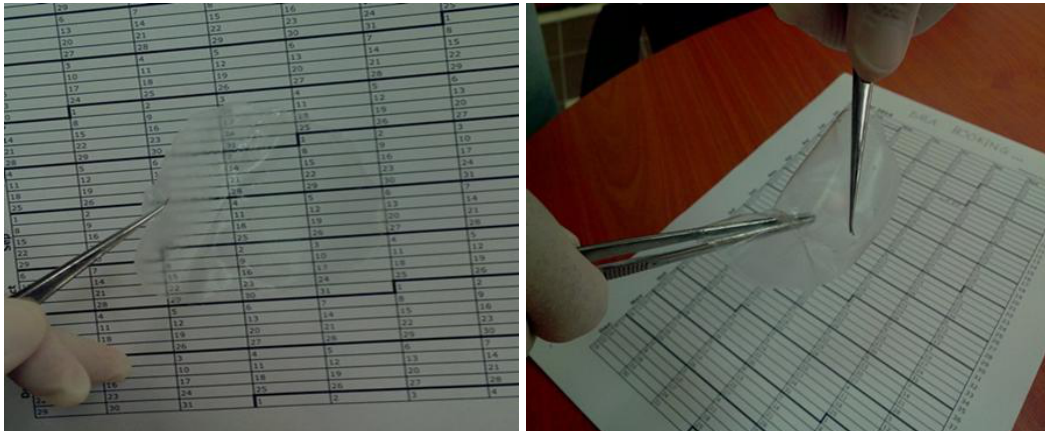
Figure 3. Photograph of the transparent film CMC–CH